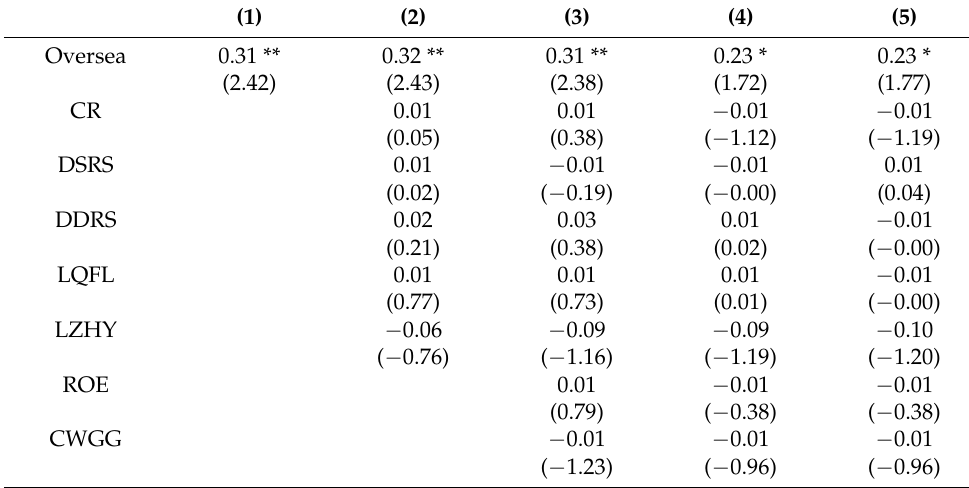
Table 4. Mixed sample regression